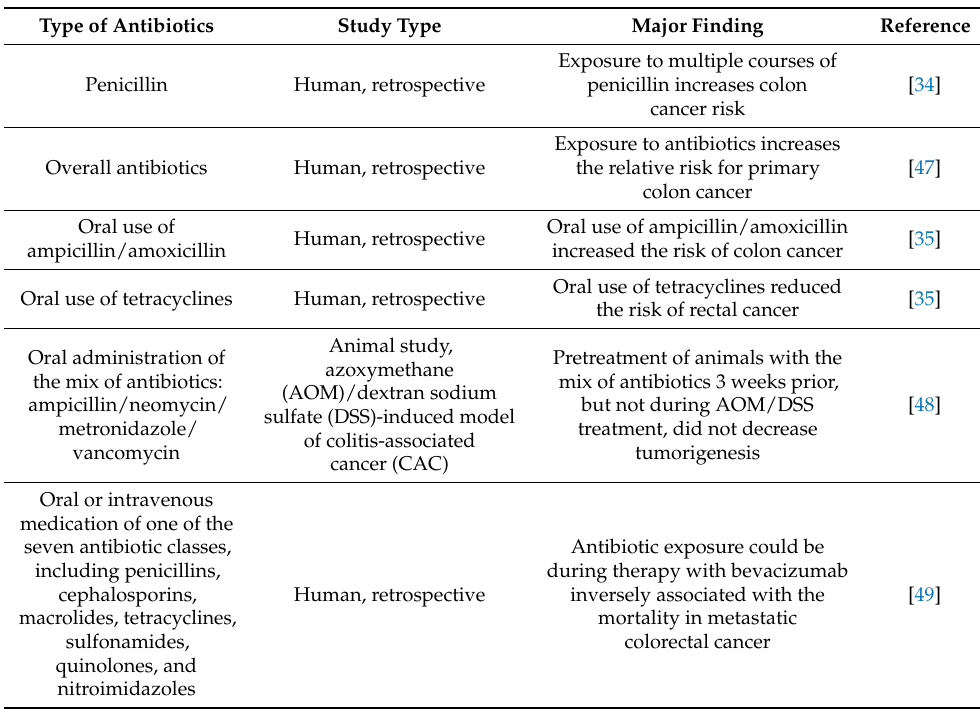
Table 1. Summary of studies on the role of antibiotics in colon and rectal